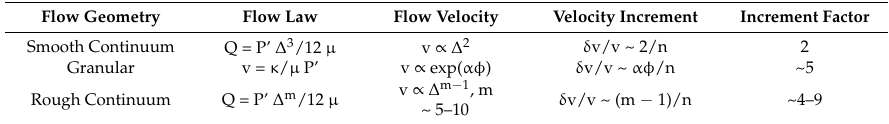
Table 1. The relative effect of incremental permeability increases for smooth and rough Poiseuille flow and for granularity percolation flow for empirics (I)–(III)